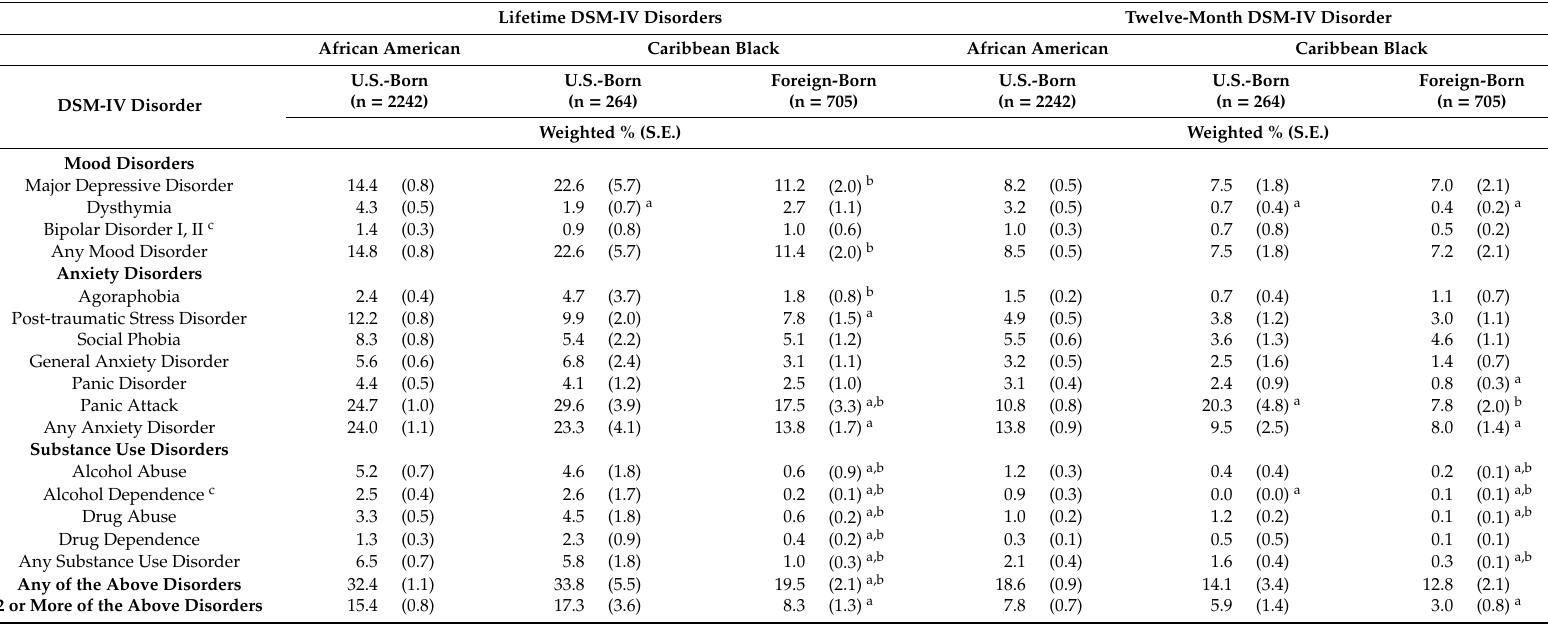
Table 3. Weighted prevalence of lifetime DSM IV / WMH-CIDI mood, anxiety, and substance use psychiatric disorders among black women in the National Survey of American